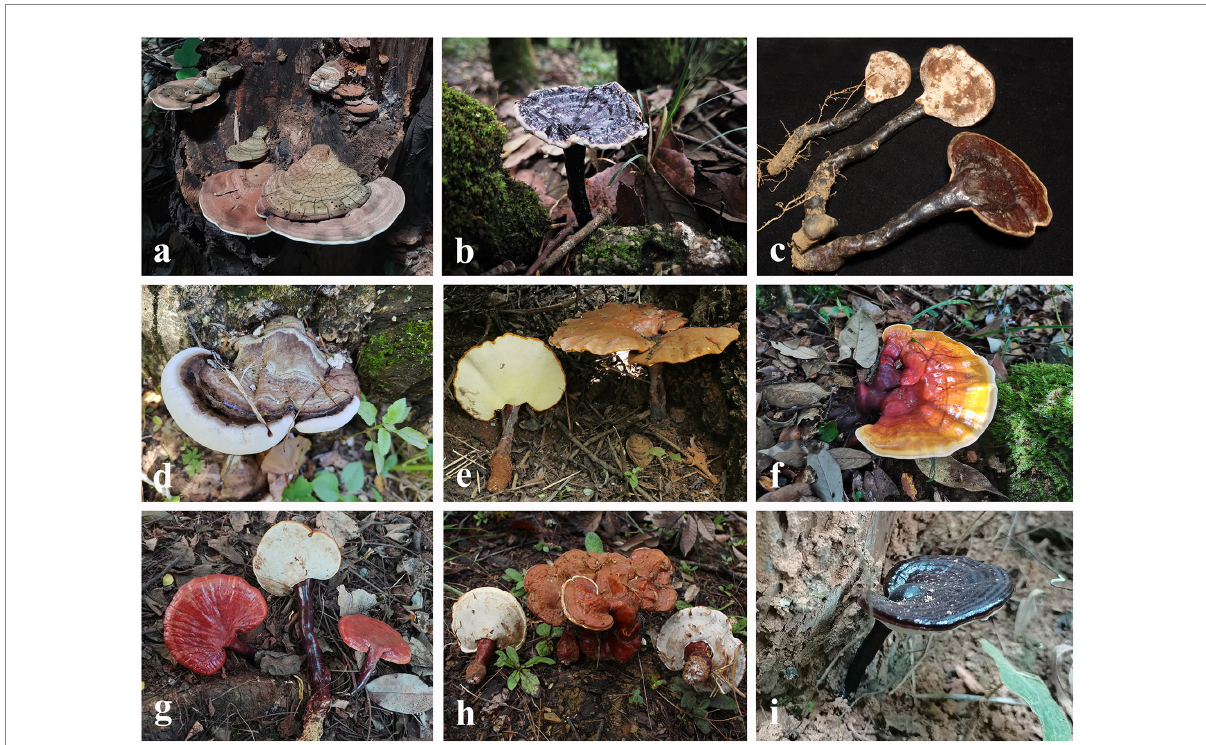
FIGURE 1 Basidiomata of the Ganoderma species collected in Yunnan Province, China. (A) Ganoderma applanatum found in Eriobotrya tree (HKAS123785); (B) Ganoderma dianzhongense in Cyclobalanopsis tree (HKAS 112719); (C) Ganoderma esculentum (HKAS123789); (D) Ganoderma gibbosum in Carya tree (HKAS123781); (E) Ganoderma lingzhi in Prunus tree (HKAS123768); (F) Ganoderma leucocontextum in Cyclobalanopsis tree (HKAS123767); (G) Ganoderma lucidum in Quercus tree (HKAS123773); (H) Ganoderma multipileum (HKAS123775); (I) Ganoderma sinense in Acer tree (HKAS123770). Photographs were taken by